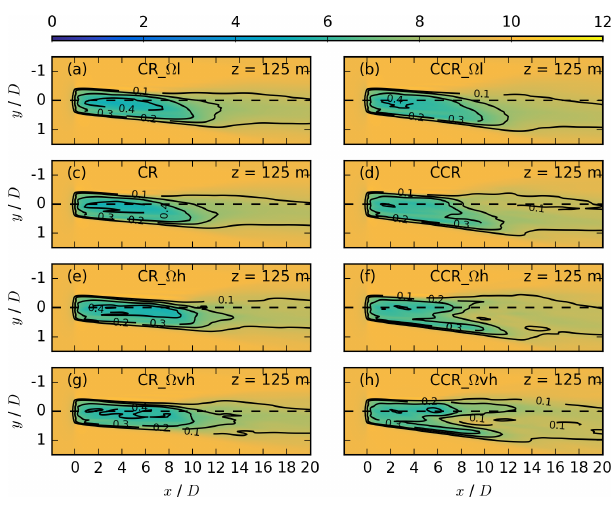
in meters Figure 15. Contours of the streamwise velocity u i,j,k ∗ per second for different rotational frequencies at z = 125m for the same simulations as in Fig. 14. The black contours represent the velocity deficit VD i,j,k at the same vertical ∗